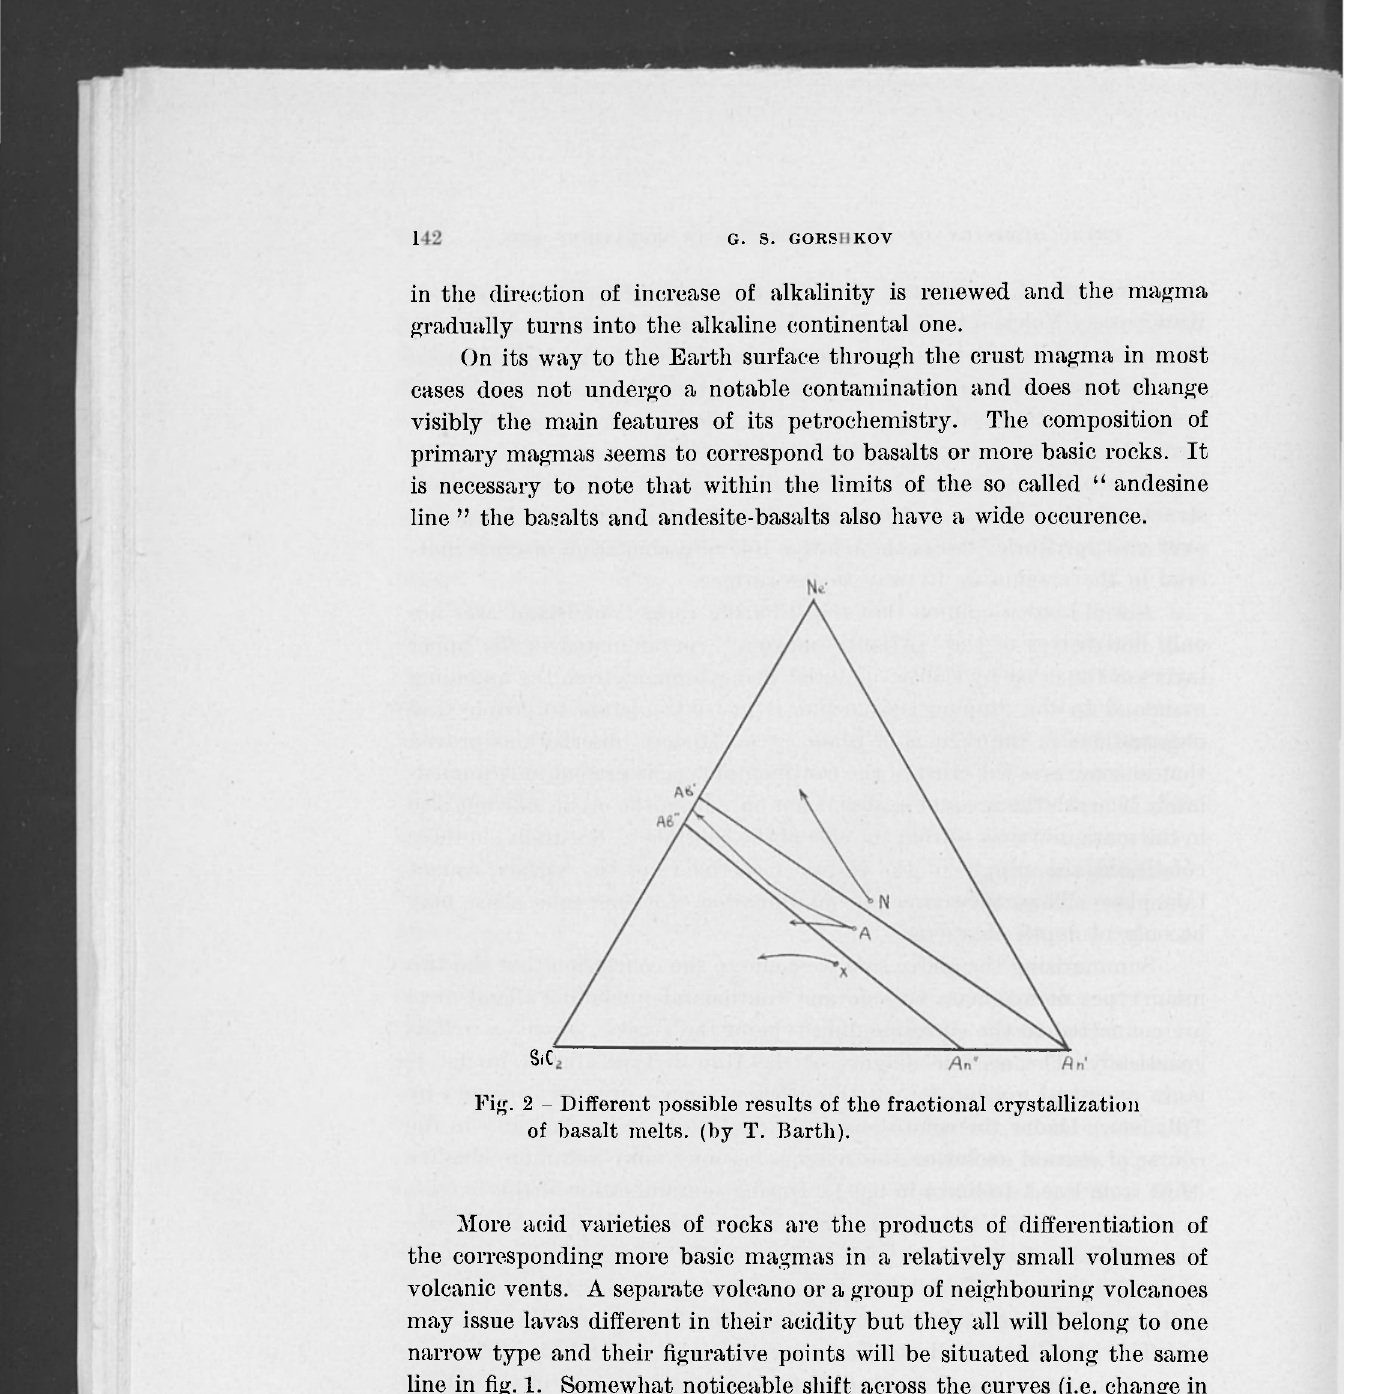
Fig. 2 - Different possible results of the fractional crystallization of basalt melts, (by T.